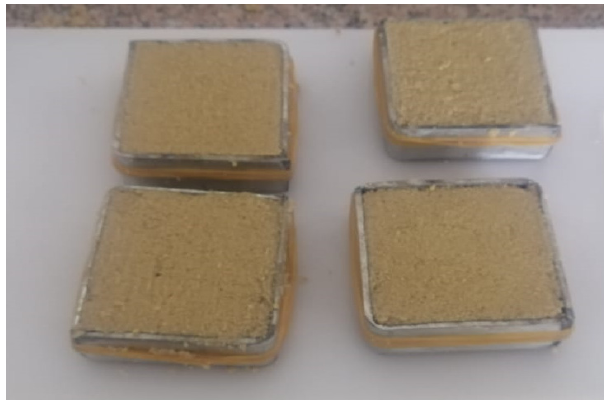
Figure 4. Samples of stabilized sand in molds.